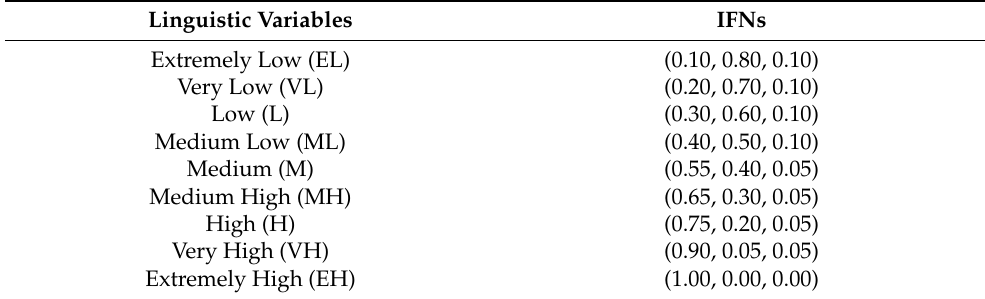
Table 6. The transformation relationship of directly affected matrix linguistic variables.